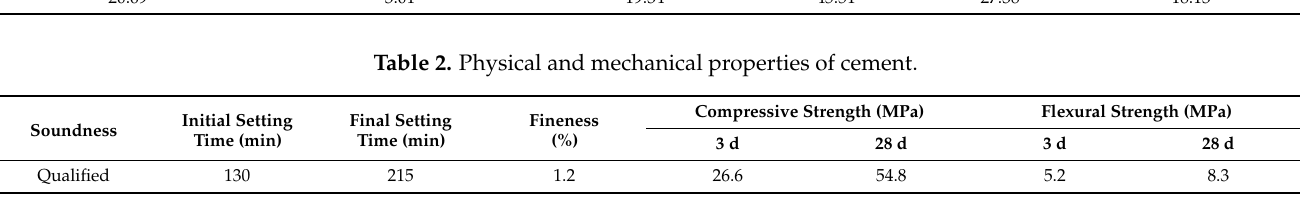
Table 3. Physical index of fly ash.